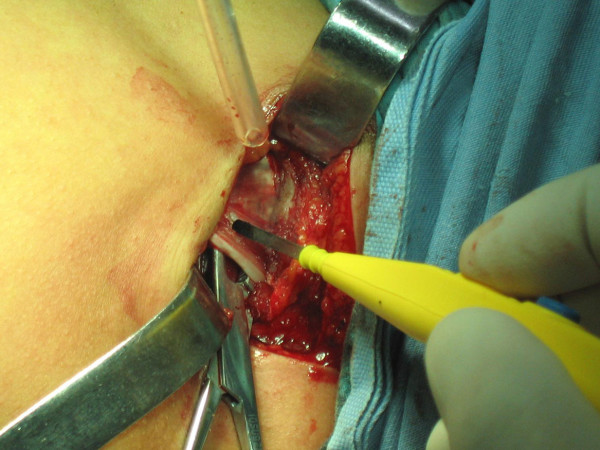
Intraoperative view of the lesion of contraction.